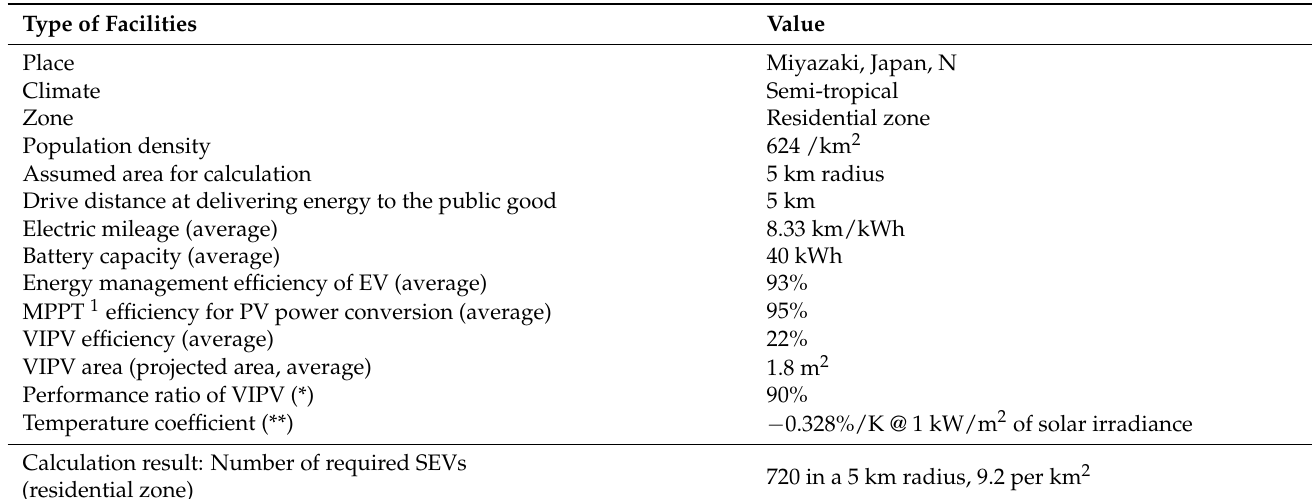
Table 6. Summary of the Monte Carlo simulation of SEV-based energy